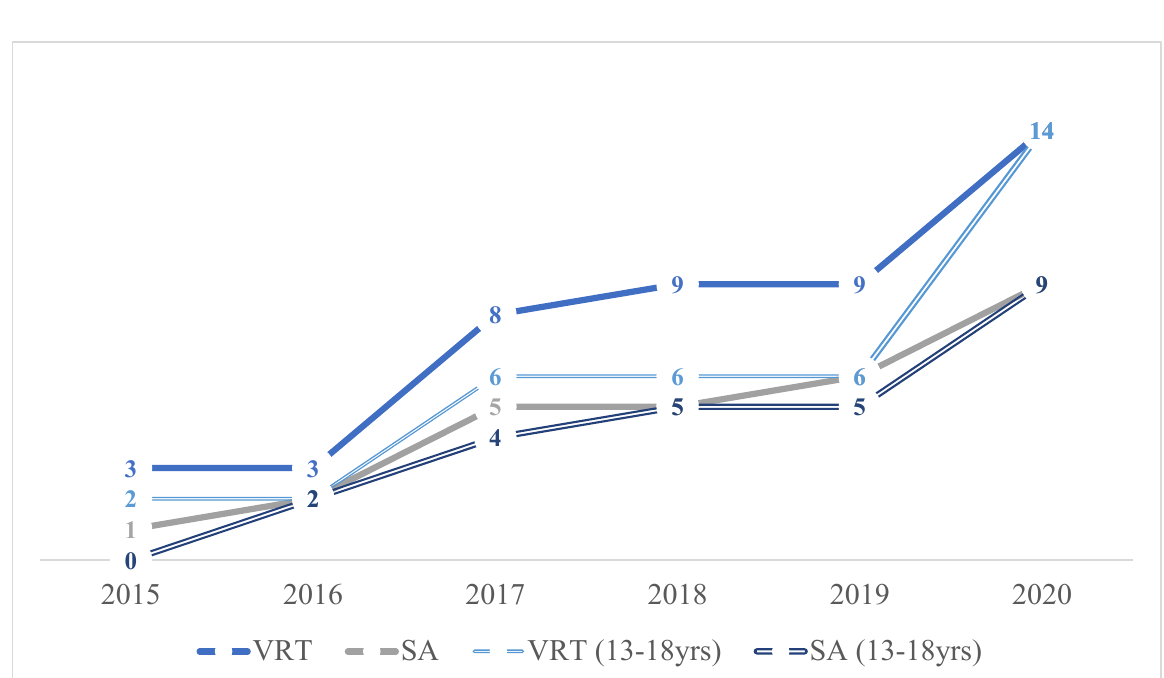
No differences in gender distribution, mean age and type of trauma—blunt vs. penetrating—arose across the study period. A significant growing percentage of VRT and suicide attempts (SAs) was observed during the study period, from 3.6% (n = 3) to 9.8% (n = 14) and from 1.2% (n = 1) to 6.2% (n = 9), respectively ( p = 0.020 and p = 0.029) (Figure 2).